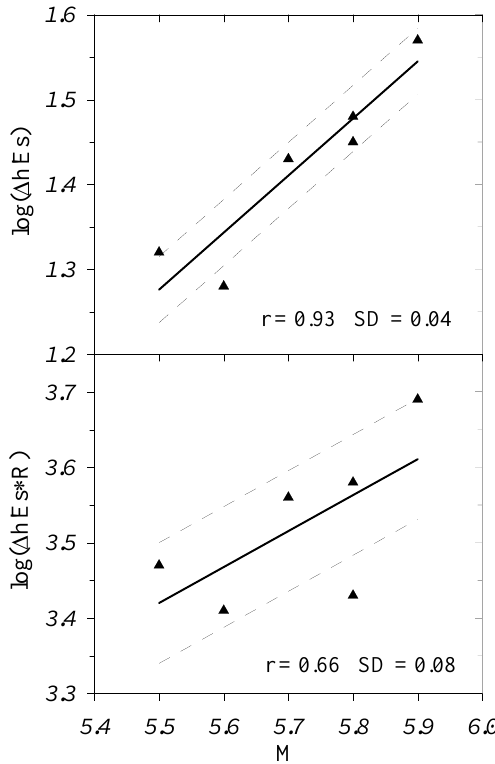
Fig. 3. The observed dependencies for log( 1T ) and log( 1T · R ) on the earthquake magnitude. Correlation coefficients ( r ) and standard deviations (SD) of the points from the regression line are given. Notice that inclusion of the epicenter distance R improves to some extent the dependence (bottom panel). Dashes are ± SD. Both de- pendences are significant at 99% confidence level.